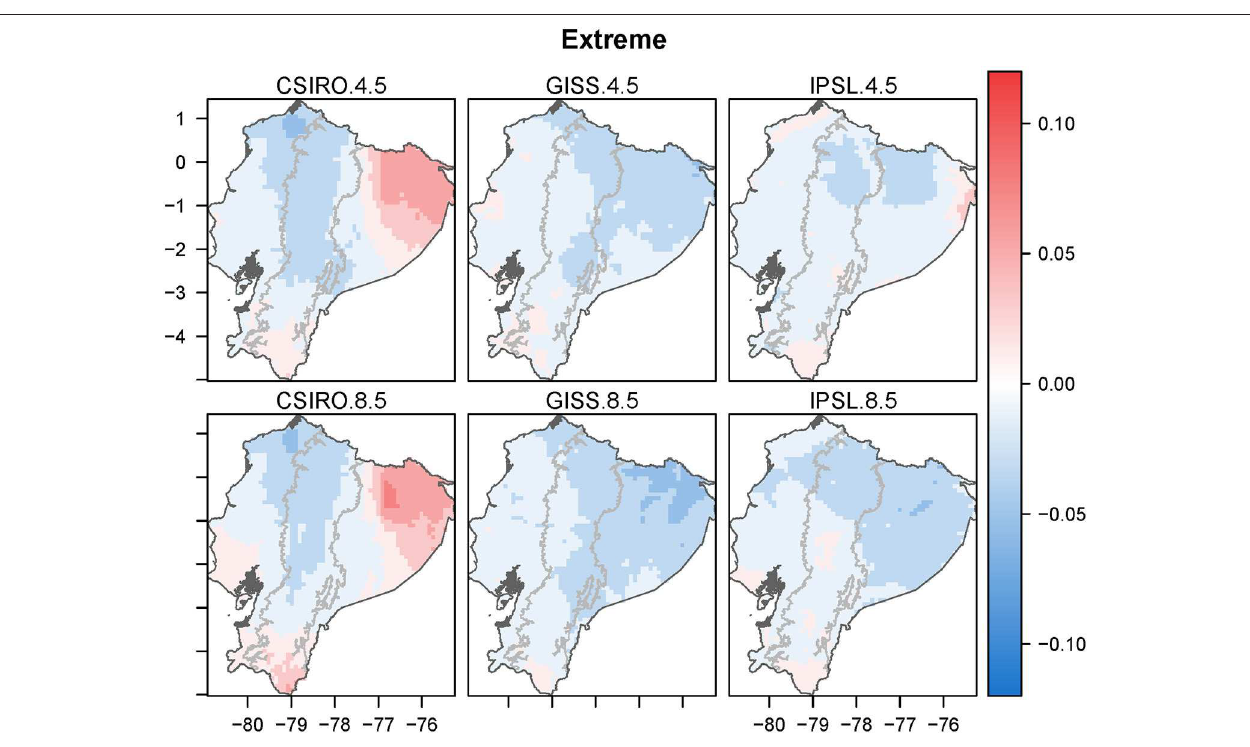
Frontiers in Earth Science | www.frontiersin.org